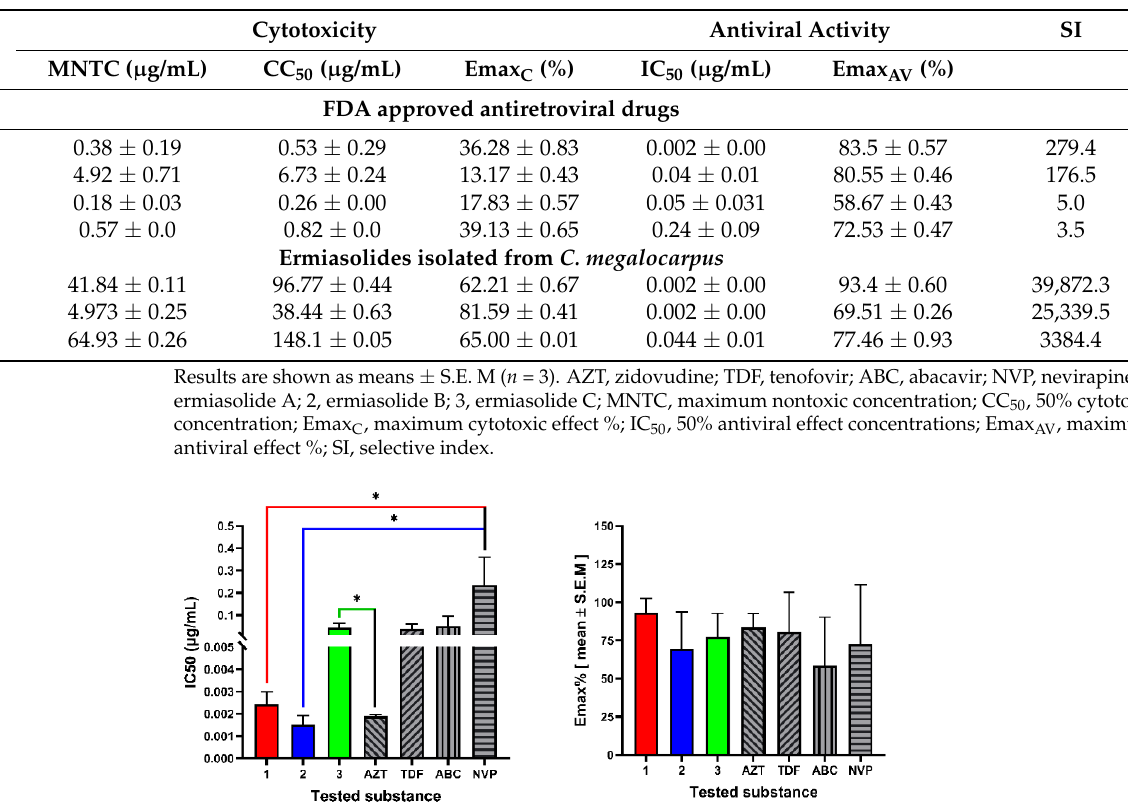
Table 2. Cytotoxicity and anti-HIV-1 activities of ermiasolides from C. megalocarpus .